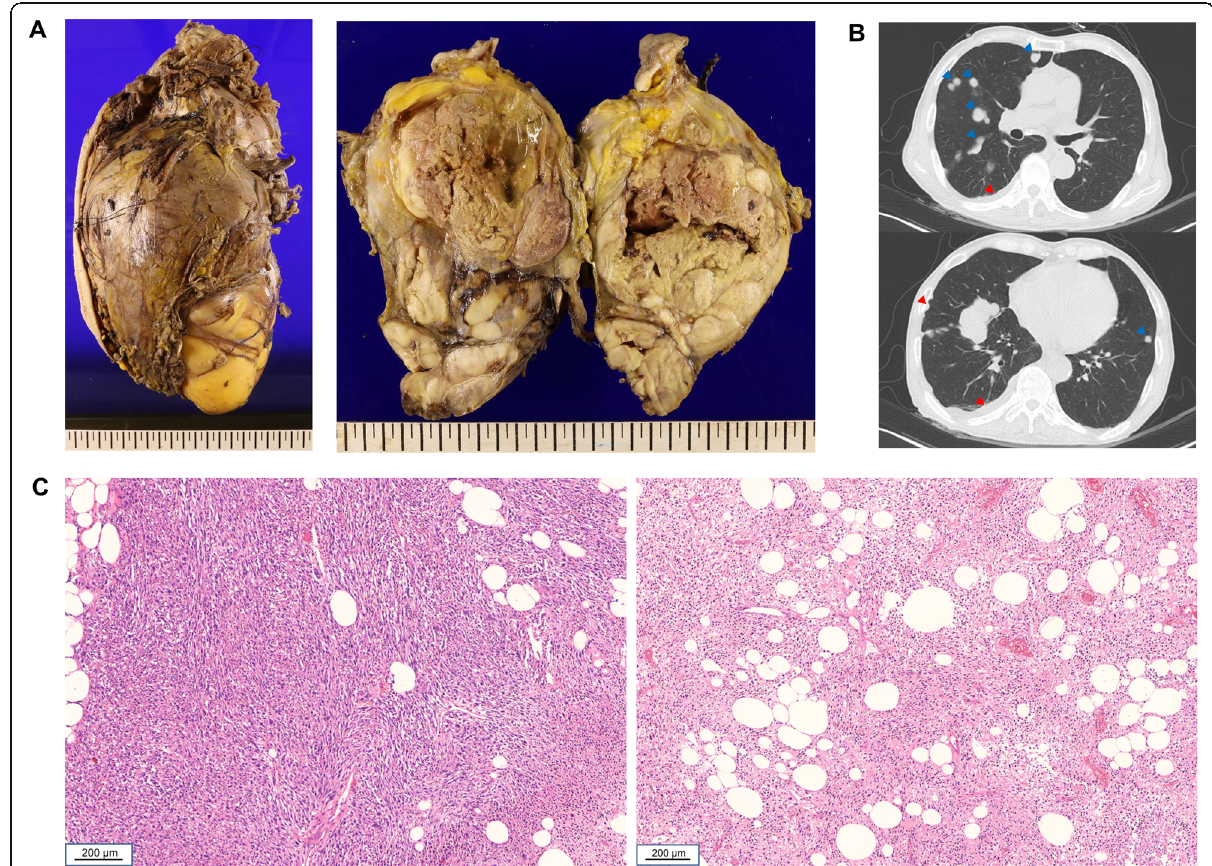
Fig. 1 Pathological and radiological features of the DDLPS case. a On gross pathology, tumor showed well circumscribed tumor mass with internal multilobulated areas. b Multiple lung (blue arrow) and pleural metastases (red arrow) were detected by chest computed tomography. c Histological findings of representative tumor area showed dedifferentiated areas with spindle cells without lipogenic portion (left panel) and less dedifferentiated areas with round cells with lipogenic portion (right panel) (hematoxylin and eosin, original magnification, ×